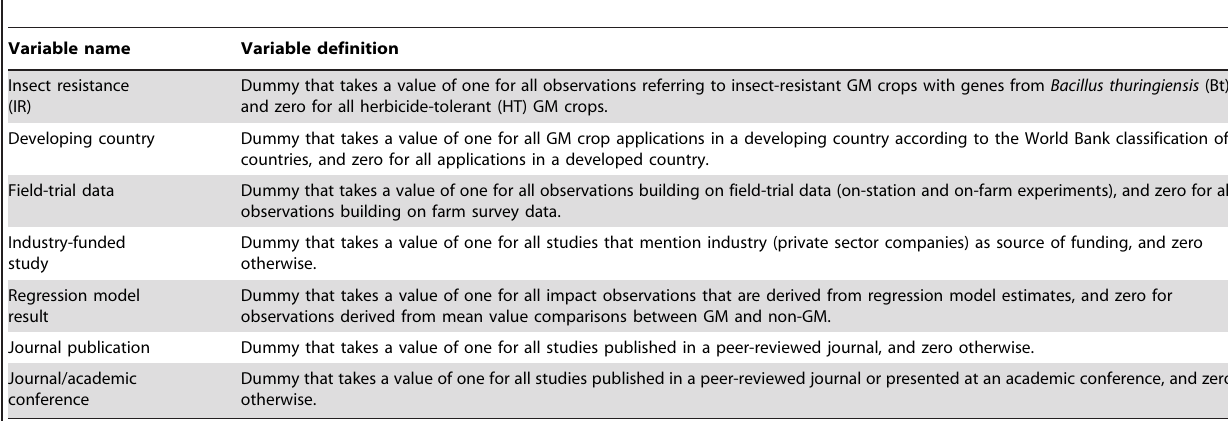
Table 1. Variables used to analyze influencing factors of GM crop